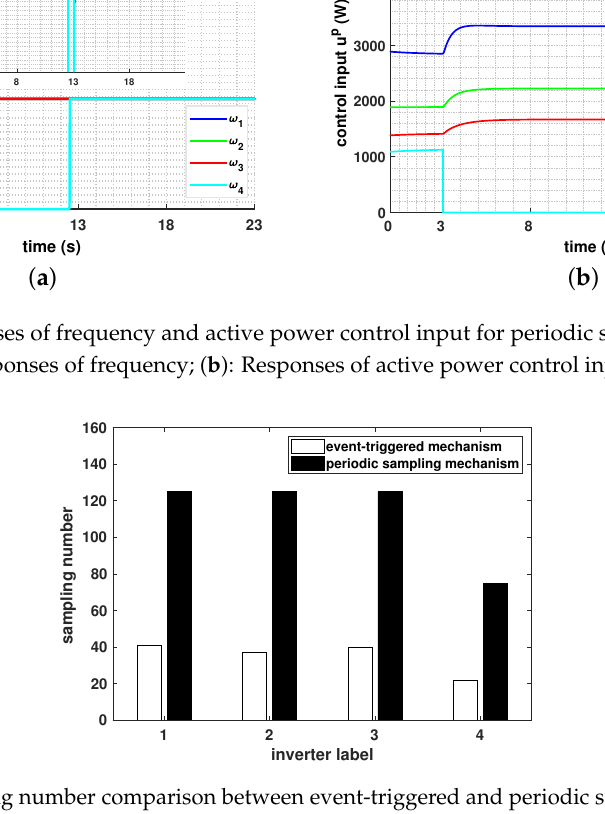
Figure 14. Sampling number comparison between event-triggered and periodic sampling mechanisms in Case